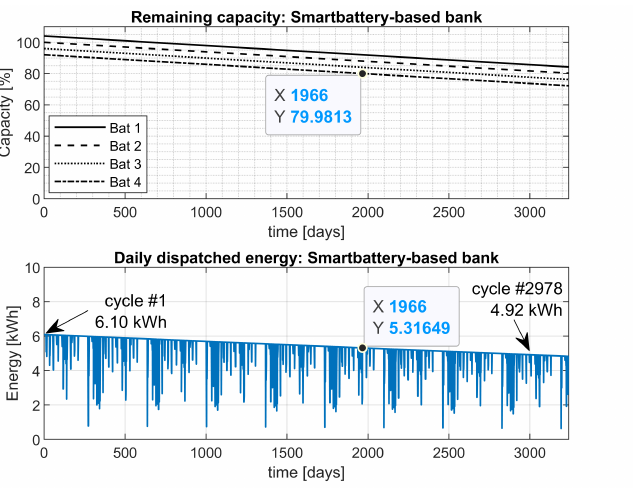
Figure 15. SoC and current profiles for actively connected lithium batteries.